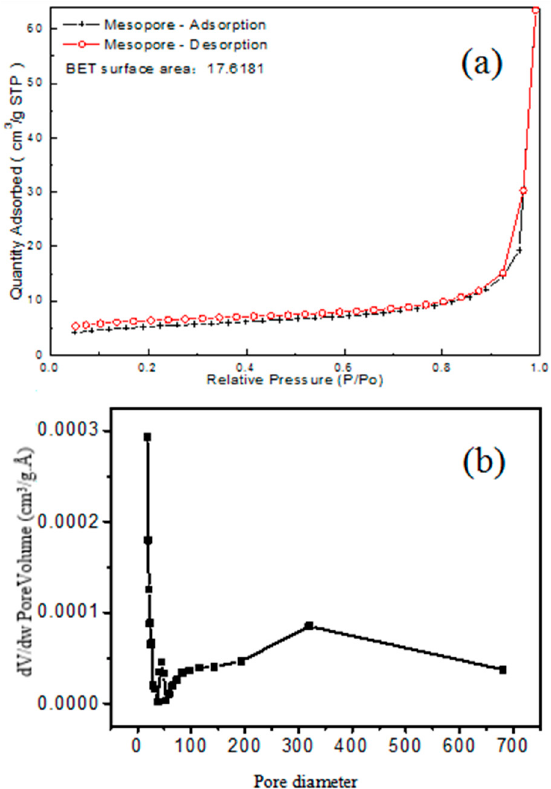
Figure 4. ( a ) Typical N 2 -gas adsorption–desorption isotherms and ( b ) the corresponding pore-size distribution of the HWHMS.